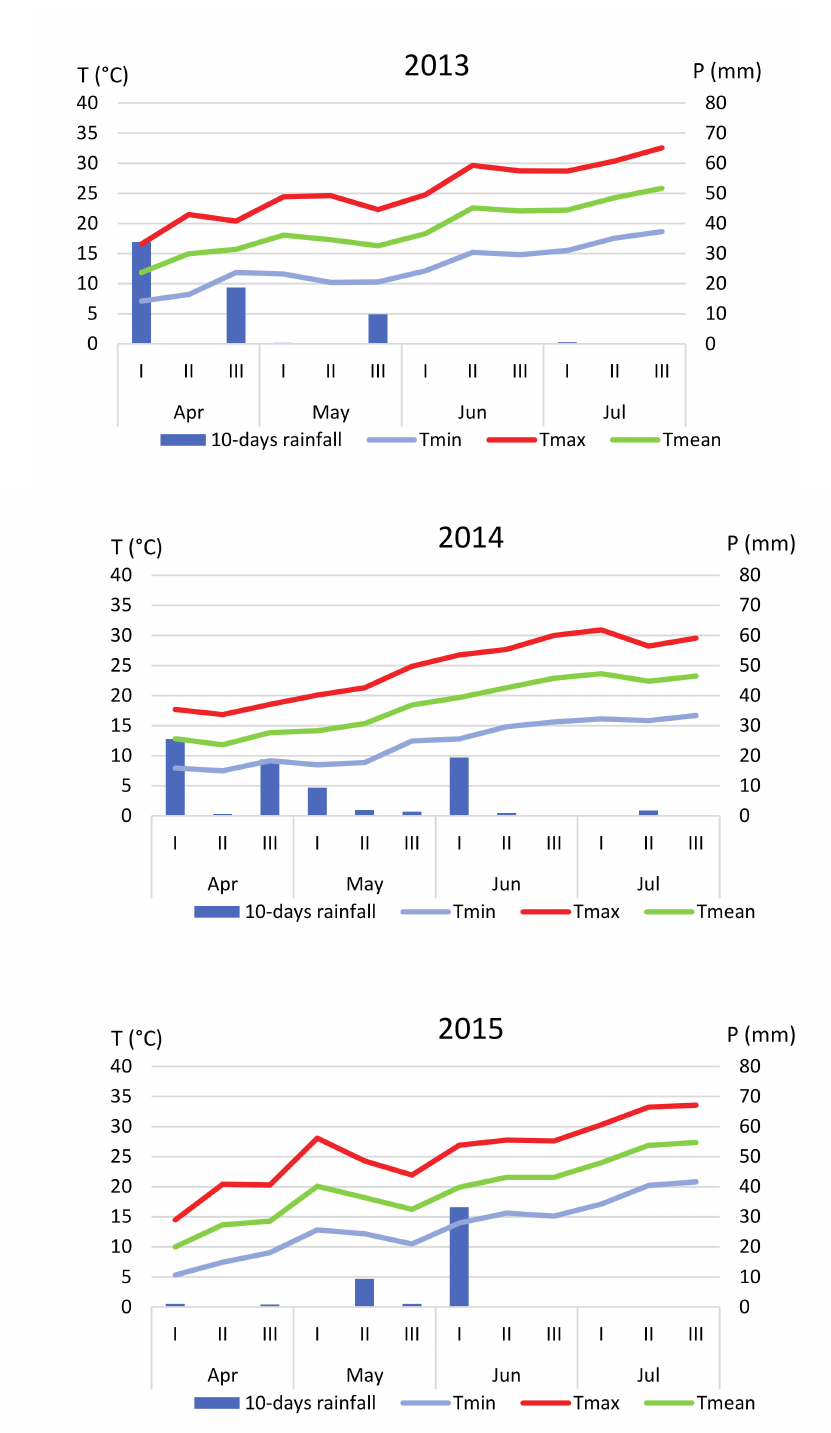
Figure 8. Ten-days values of rainfall (mm) and temperatures ( ◦ C) recorded from April to July in 2013, 2014 and 2015 in the meteorological station “Canicatt ì ” (farm